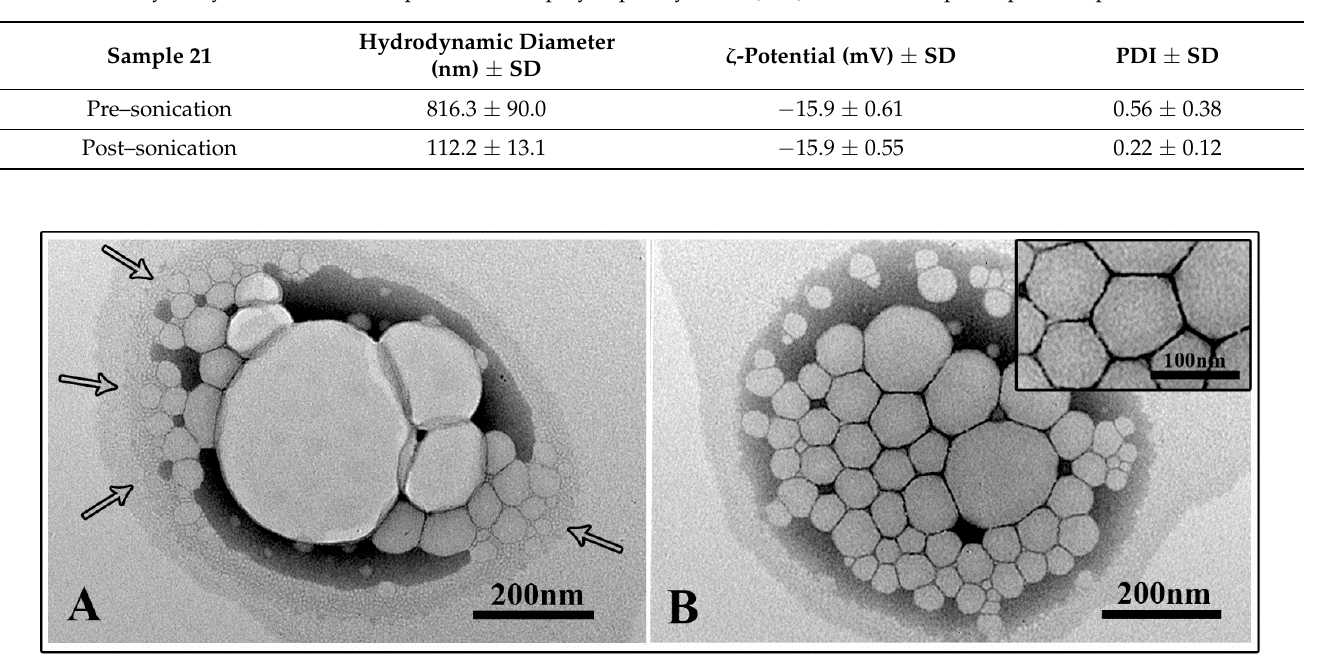
Figure 3. Electron microscopic observations of selected nanoemulsions (NEs) (sample 21). (Panel A ): pre-sonication sample (arrows indicate NEs partially fused within the matrix). (Panel B ): post-sonication sample (insert showed NEs well separated, and with a size comparable to DLS values).